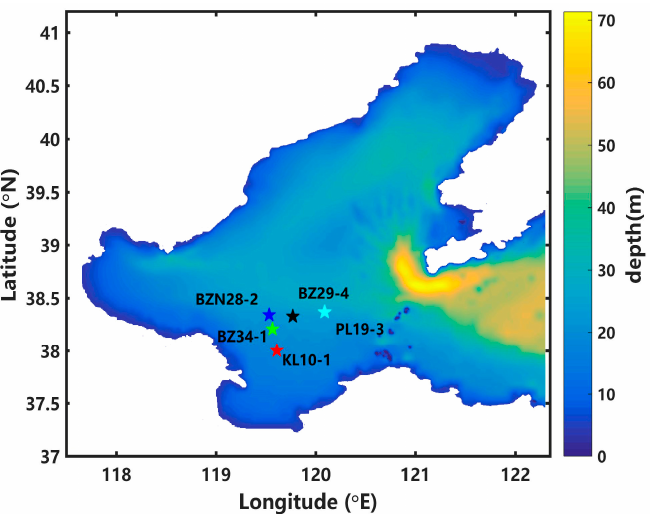
Figure 1. Depth map of the Bohai Sea and distribution of the oil platforms.